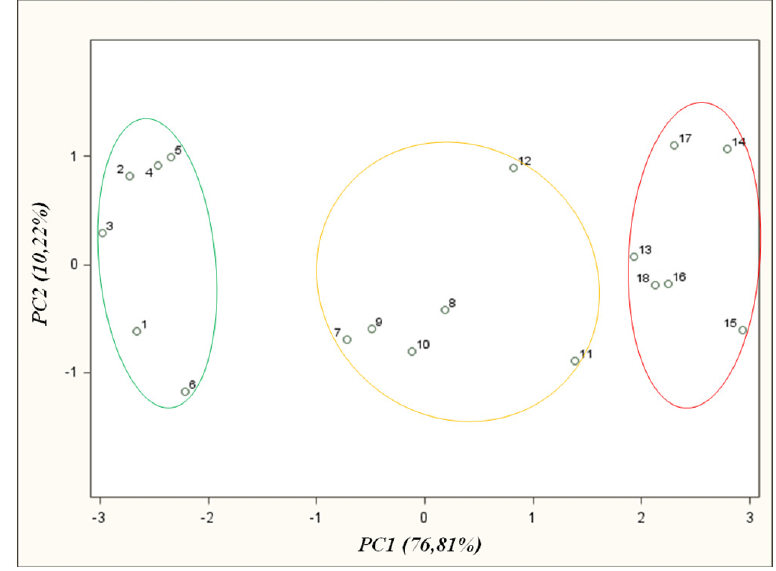
Figure 6. PCA results for samples of agricultural distillates obtained for optimum conditions of barbotage process and optimum operation parameters of electronic nose prototype; points: 1–6—high quality class distillates (green), 7–12—medium quality class distillates (yellow), 13–18—low quality class distillates